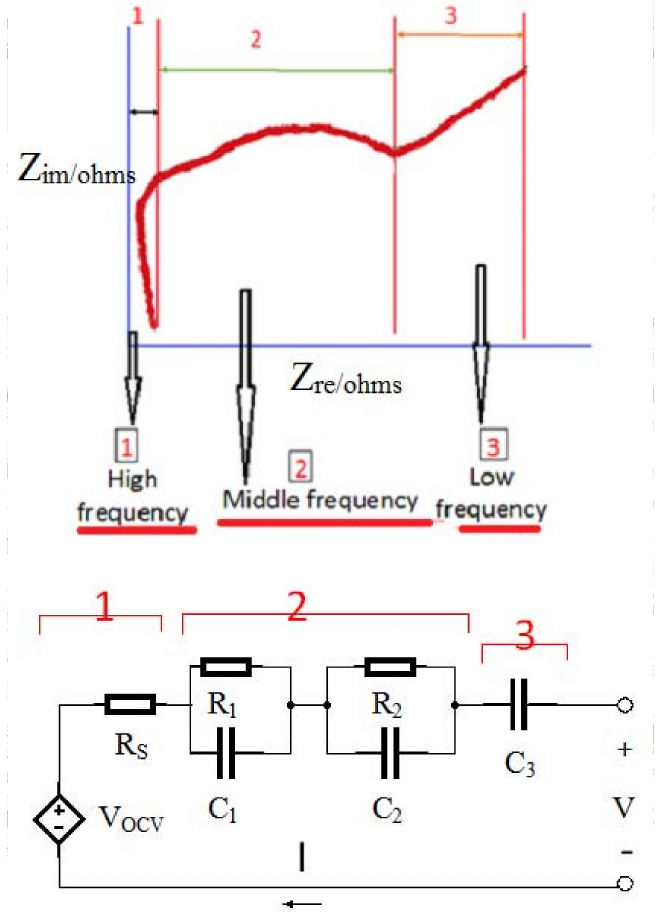
Figure 6. ECM based on the EIS feedback of the lithium-ion battery